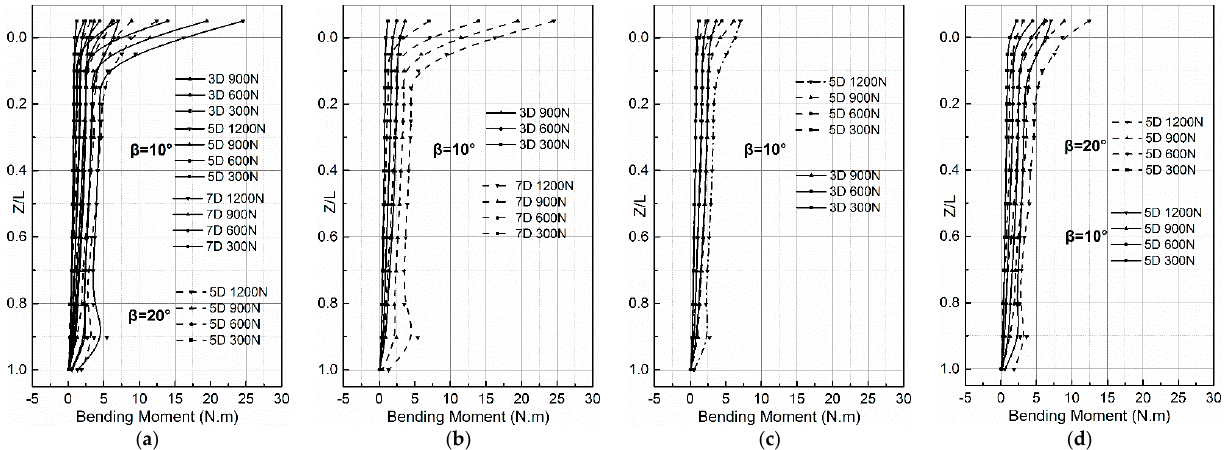
Figure 11. The variation in bending moment of the symmetrical batter pile under vertical loading: ( a ) the bending moment of all tests, ( b ) β = 10° pile spacing = 3 D vs. 5 D , ( c ) β = 10° pile spacing = 3 D vs. 7d, and ( d ) pile spacing = 5 D β = 10° vs. 20.